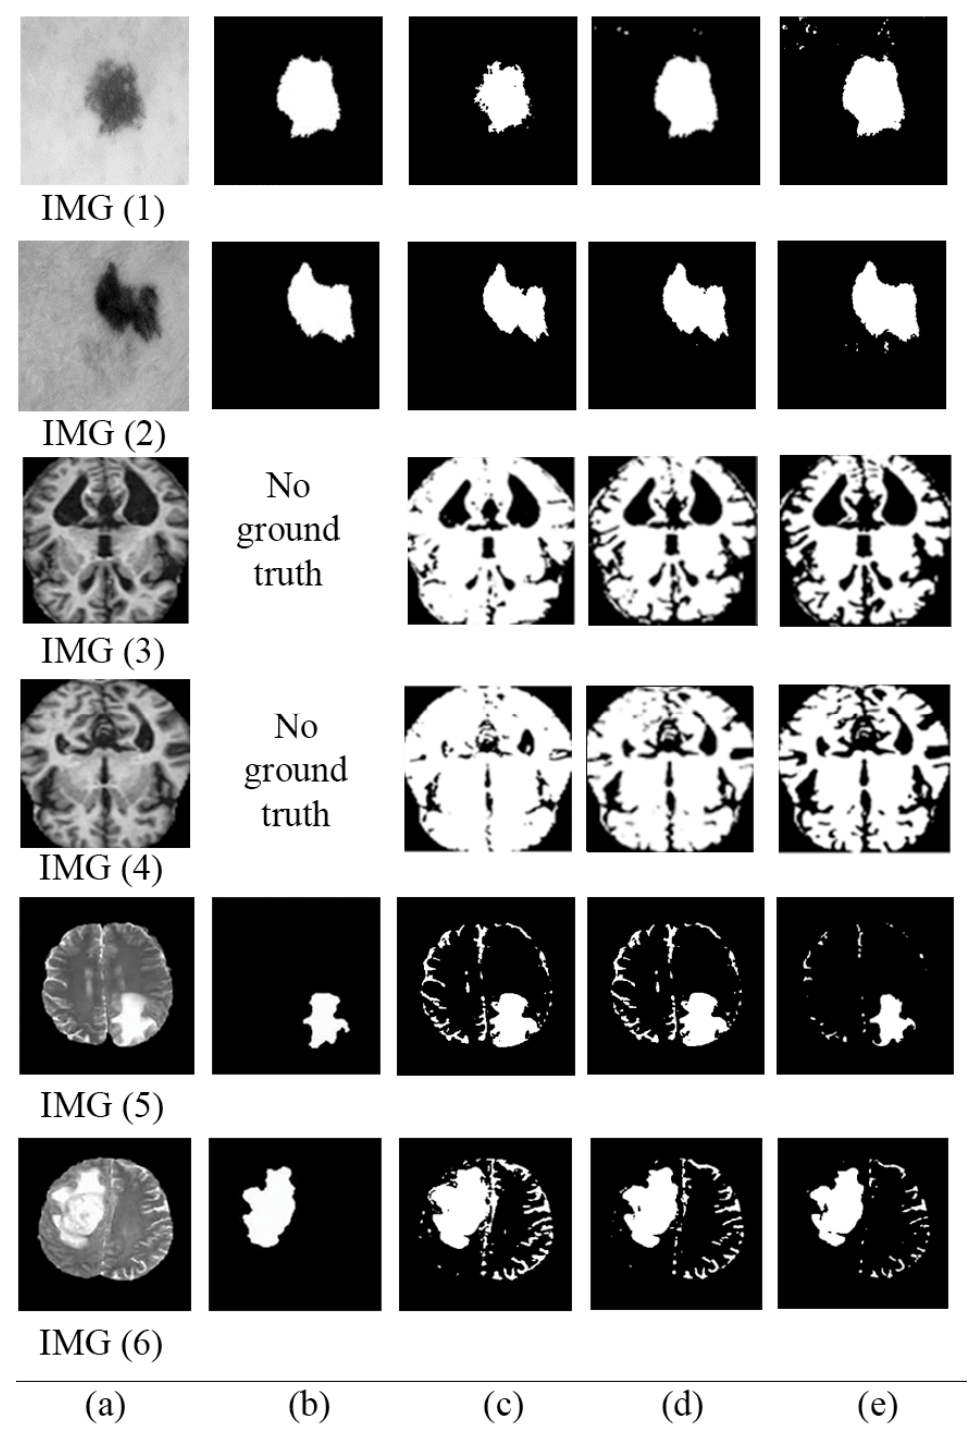
Figure 6. Samples of segmented images ( a ) original images, ( b ) ground truths, ( c ) segmented images using the original MECT, ( d ) segmented images using MCET based on homogeneous mean filter approaches, ( e ) segmented images using the proposed MCET based on heterogeneous mean filter approaches.